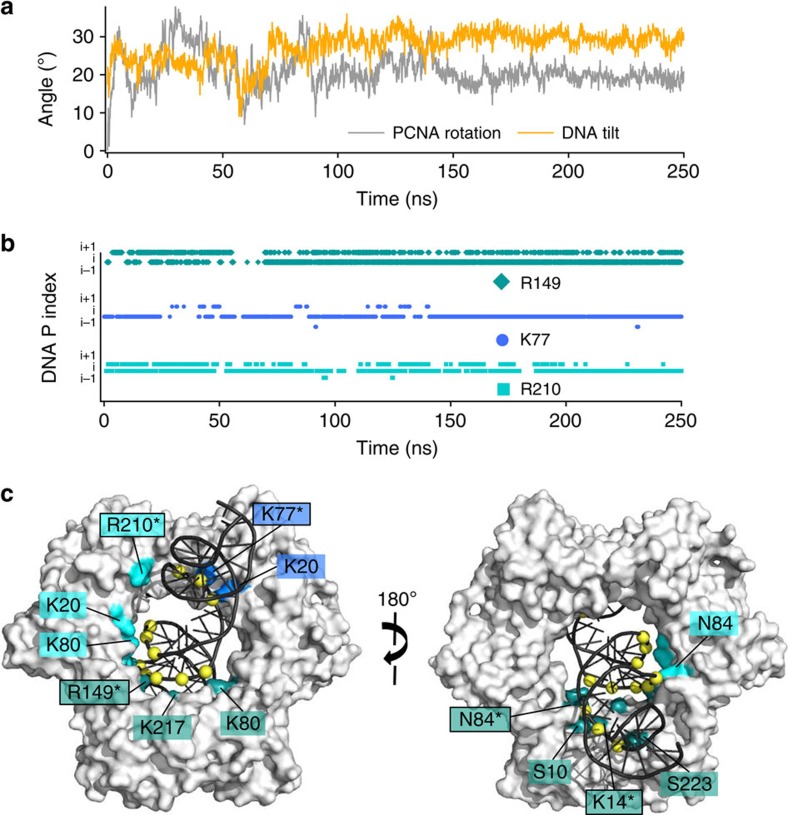
MD simulation of human PCNA bound to a 30 bp DNA.(a) PCNA ring rotation and evolution of DNA tilting relative to the ring C3 axis (b) Time evolution of contacts between the side chain nitrogens of three representative PCNA interfacial residues and DNA phosphorus atoms at consecutive positions (c) Two views of the PCNA–DNA complex at the end of the MD trajectory. PCNA is shown as a grey surface and DNA as a black ribbon. PCNA residues whose side chains are engaged in polar contacts with DNA phosphates for >25% of the MD trajectory are labelled. Residues from different PCNA subunits are coloured in shades of blue. Residues that exchange between two or three consecutive DNA phosphates for >75% of the MD simulation are indicated by an asterisk and boxed.